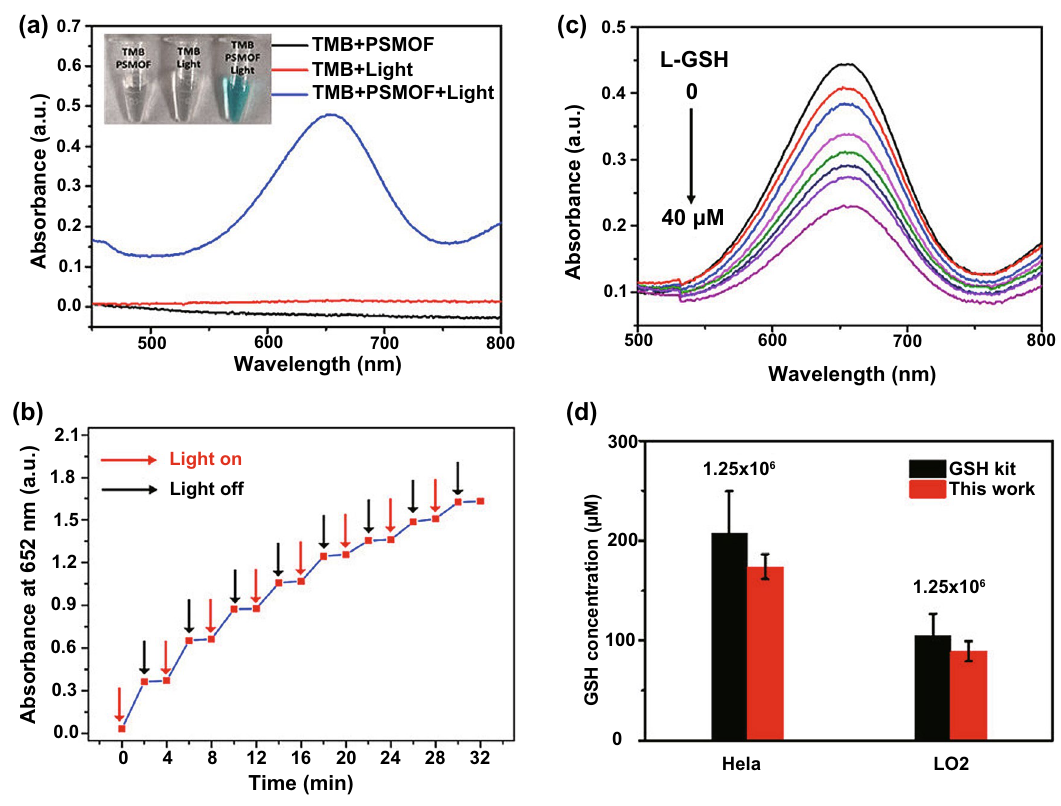
Fig. 6 a UV−Vis absorption spectra and photo of different samples as indicated. b Light-controlled OXD-mimicking ability of PSMOF. c UV– Vis absorption spectra of PSMOF-oxidized TMB incubated with different concentrations of GSH. d Intracellular GSH concentrations measured by the developed system and a commercial GSH detection kit. Reproduced with permission from Ref. [105]. Copyright 2019, Ameri- can Chemical